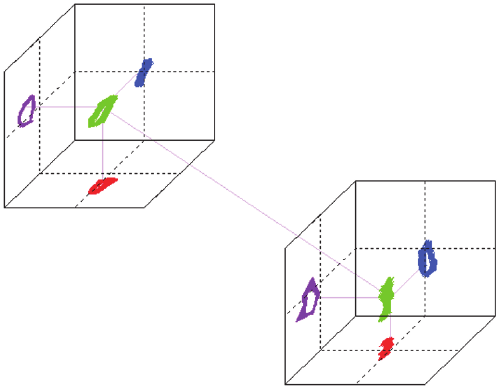
Figure 4: Two-section three-dimensional axis orbit.